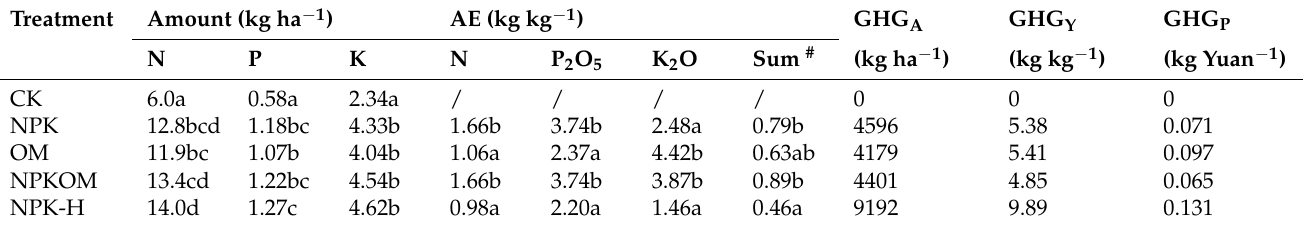
* Different letters following data of the same line indicate significant difference among treatments. 262 # Sum represents N+P 2 O 5 +K 2 O.